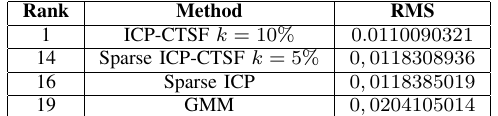
Fig. 12: (a) RMS for missing data simulation (b) Point cloud 0 ◦ and its version rotated/translated and corrupted by removing data. (c) Best alignment obtained by ICP-CTSF with k = 10% . (d) Alignment generated by Sparse ICP-CTSF with k = %5 . (e) Worst alignment obtained by Sparse ICP. TABLE V: RMS for alignment of clouds with missing data.